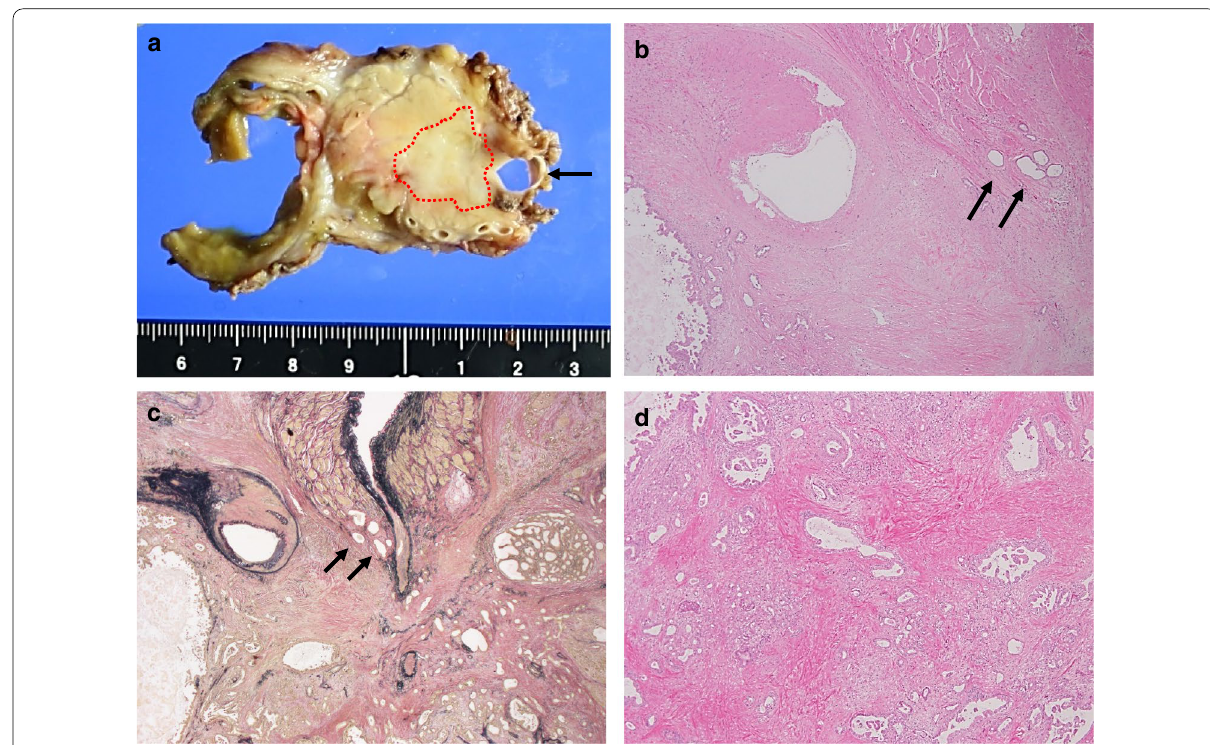
Fig. 5 Macroscopic and microscopic view of the resected specimen. a The cut section of the resected specimen shows an ill-circumscribed and whitish mass (red dot) in the pancreas, invading the portal vein (arrow) and peripancreatic fat. b – d Microscopically, tubular carcinoma was seen with sclerotic stroma, invading the portal vein (arrows in b and c ).[ b and d : hematoxylin and eosin stain, c : Elastica van Gieson